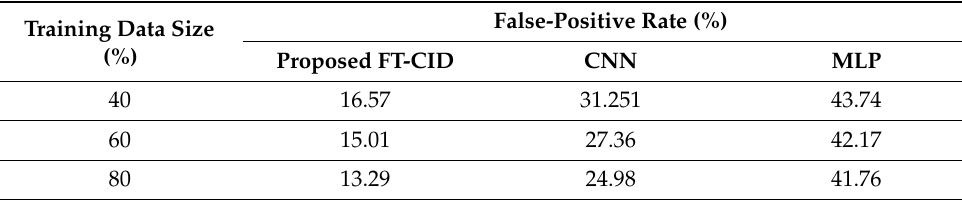
Figure 8. False-positive rate performance for FT-CID, CNN, and MLP. Table 5. Comparative experimental results of false-positive rate. Table 5. Comparative experimental results of false-positive